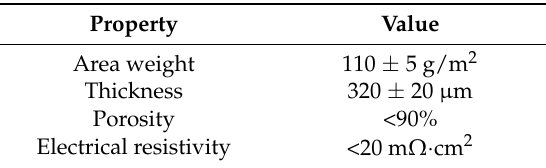
Table 1. Properties of JNT 30-A1 GDL 1